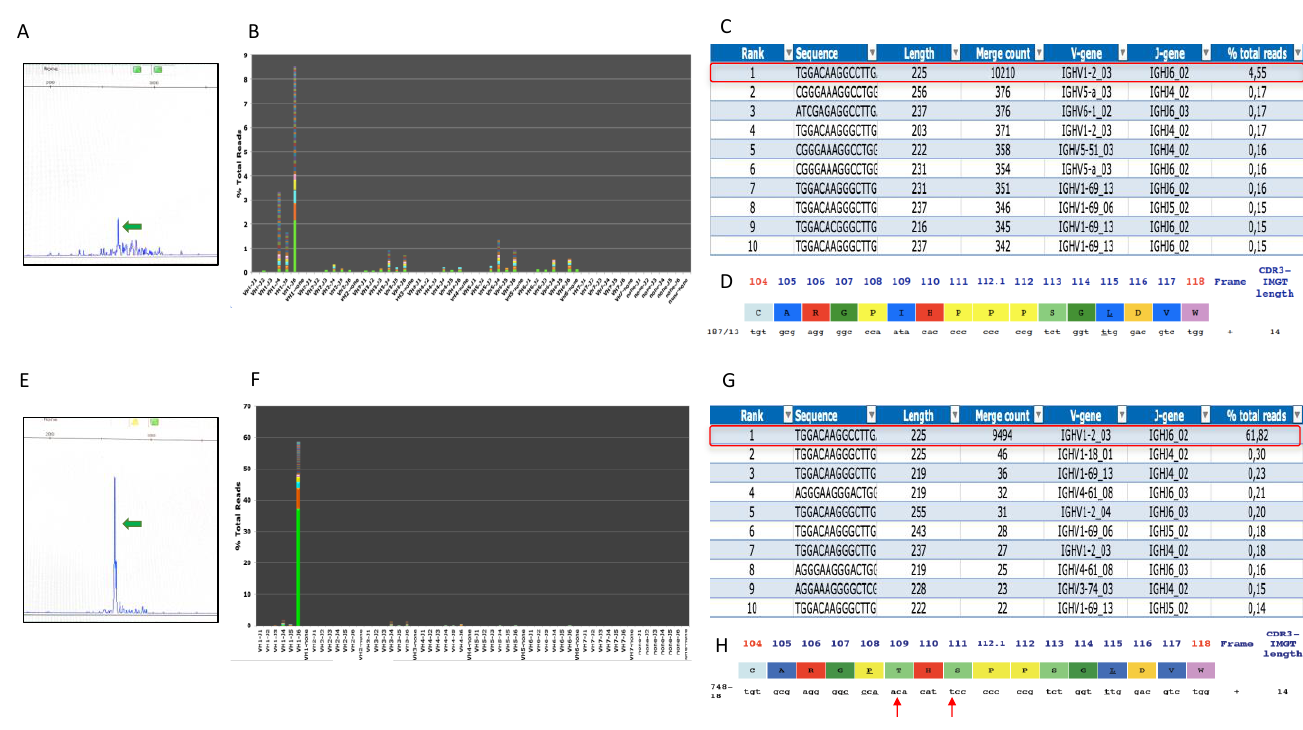
Figure 2. IGH gene rearrangement of the skin lesions of patient 1 at diagnosis ( A – C ) and at relapse ( E – G ) by PCR-based ( A , E ) and NGS-based ( B , C , F , G ) methods. Gene scan analysis of multiplex PCR analysis revealed in framework region 2 (FR2) a clonal peak (green arrows) with an identical size in both lesions ( A , E ). Snapshot of the V-J sequence frequency graph of LymphoTrack PGM Analysis Software showed in FR2 two clonal sequences with the same VH/JH gene segment use (VH1-J6) in both ( B , F ). The merged read summary output showed that the same clonotype accounted for 4.55% of total reads at diagnosis ( C ) and for 61.82% of total reads at relapse ( G ). Using the IMGT/V-QUEST program, both IGH rearrangements came out as productive with CDR3 regions of identical length and almost the same sequence ( D , H ) except for 2 nucleotides (red arrows) encoding for 2 different amino acids (letters in the colored bar).